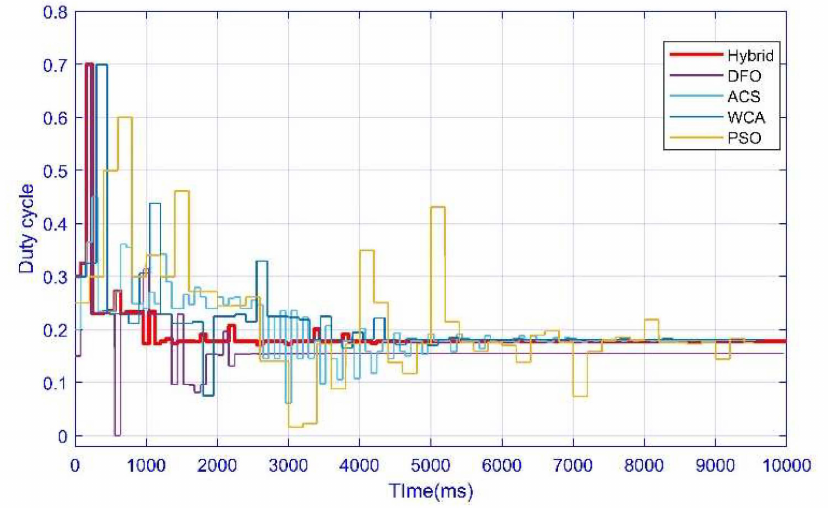
Figure 8. Case 2: Duty cycle comparison of hybrid with other techniques.